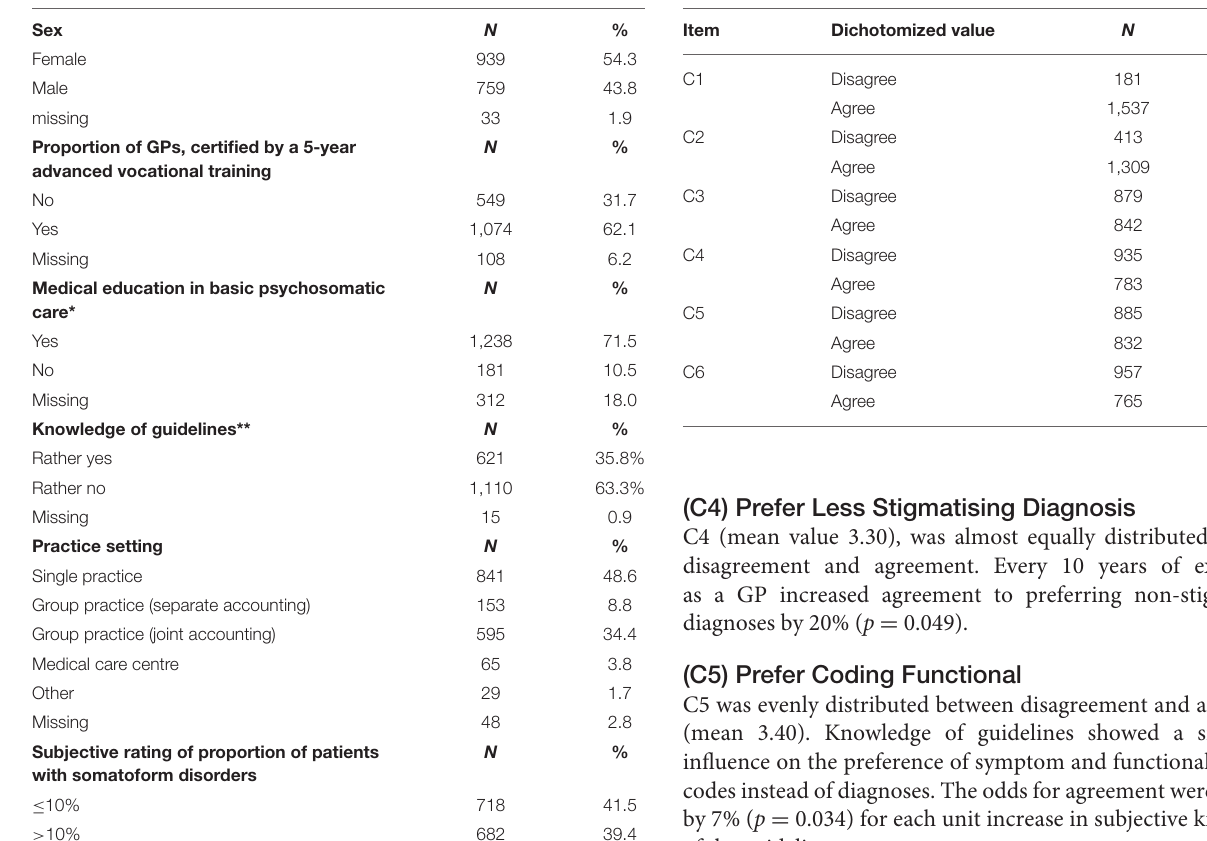
TABLE 2 | Sample characteristics ( N = 1,731, categorical variables). TABLE 3 | Proportions of agreement to coding